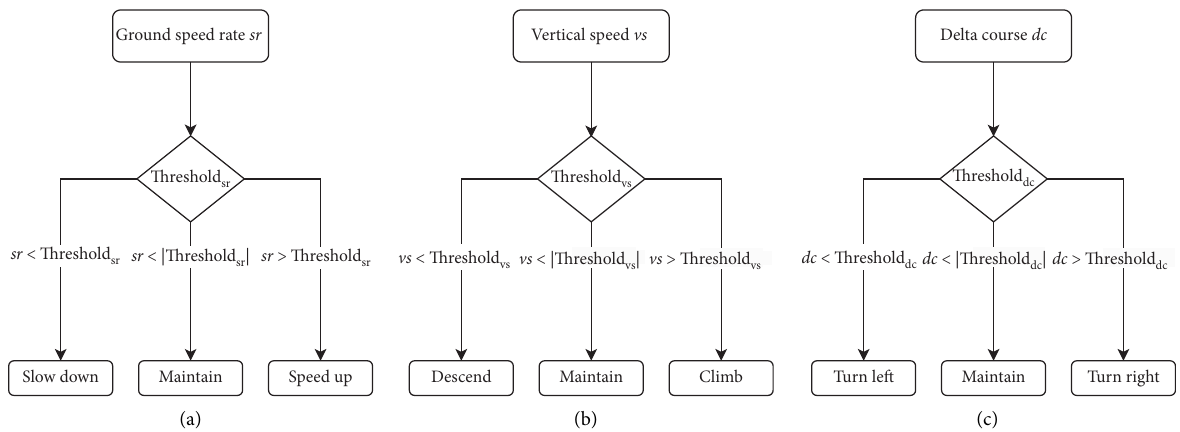
Figure 10: The illustration of the encoding step for extracting speed and vertical and course actions from continuous action